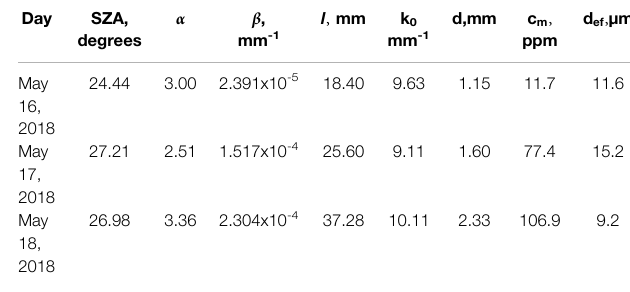
TABLE 1 | The parameters of dust – loaded snow derived at three dates at the Torgnon